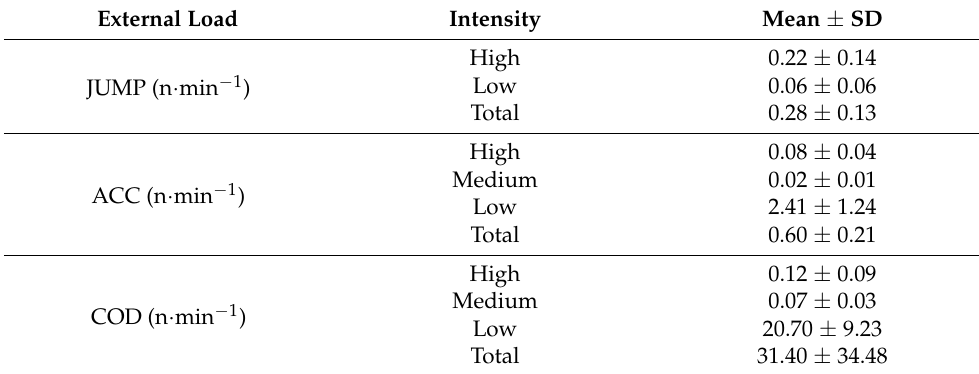
Table 2. Mean ± SD of external load measures according to their